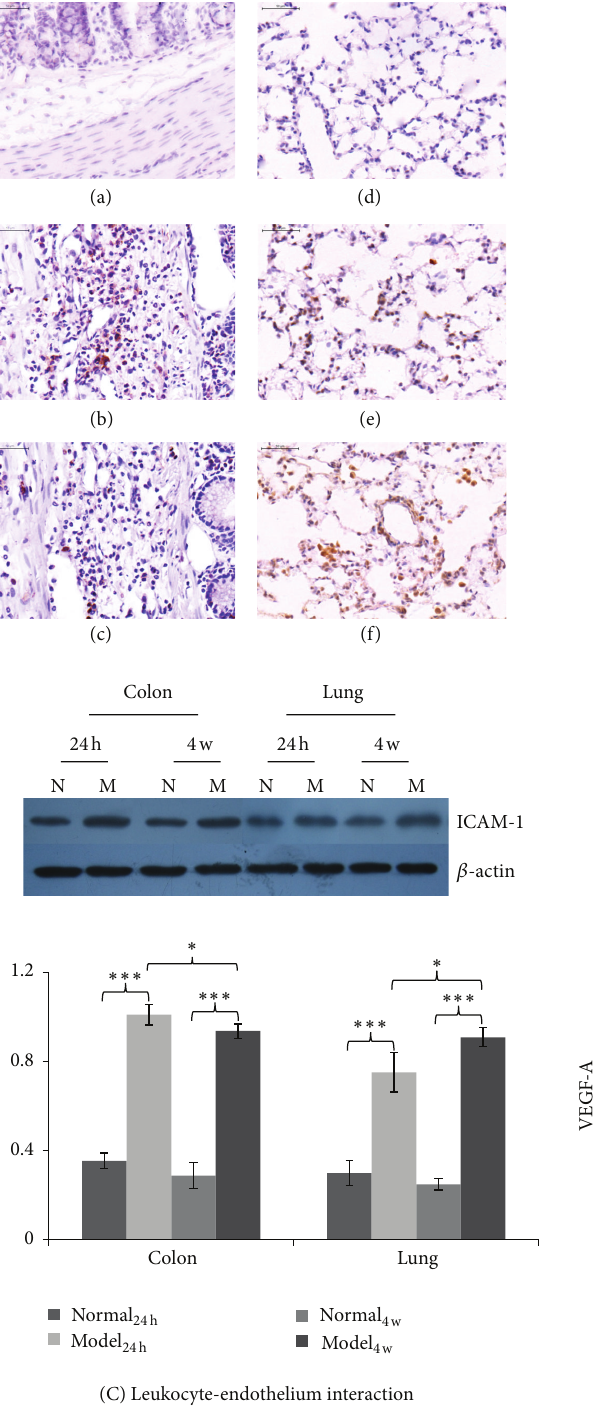
Figure 6: The role of microvasculature in the pathogenesis of ulcerative colitis. (A) Endothelial dysfunction: immunochemistry and RT- PCR results of iNOS in the colon and lung tissue homogenate. (B) Platelet activation: radioimmunoassay results of TXB 2 , 6-Keto-PGF 1𝛼 and P-selectin concentration (pg/mL) in the colon and lung tissue homogenate. (C) Leukocyte-endothelium interaction: Immunochemistry and western blotting results of ICAM-1 in the colon and lung tissue homogenate. (D) Angiogenesis: immunochemistry and western blotting results of VEGF-A in the colon and lung tissue homogenate. Band intensities were quantified using Image J software. (a) Normal colon, (b) colon, (c) model 24 colon, (d) normal lung, (e) model 24 lung, and (f) model 24 lung. Compared with the model group: ∗ , 𝑃 < 0.05 ; model 24 h w h w ∗∗ , 𝑃 < 0.01 , ∗∗∗ ; 𝑃 < 0.001 . Values are means, with error bars indicating